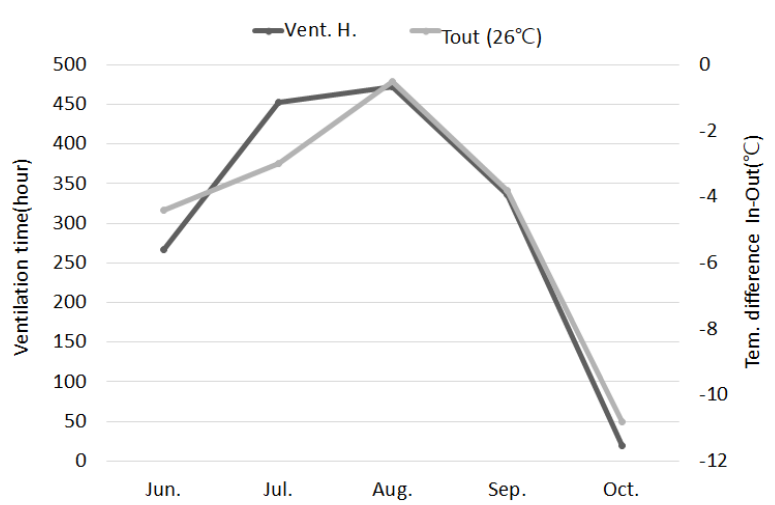
Figure 4. Comparison of the correlation between monthly hybrid ventilation operation time and the difference between the indoor set temperature and the average monthly outdoor temperature (central region). Table 6. Comparison of monthly total hybrid ventilation operating hours by variable conditions of residential units. Shape Type